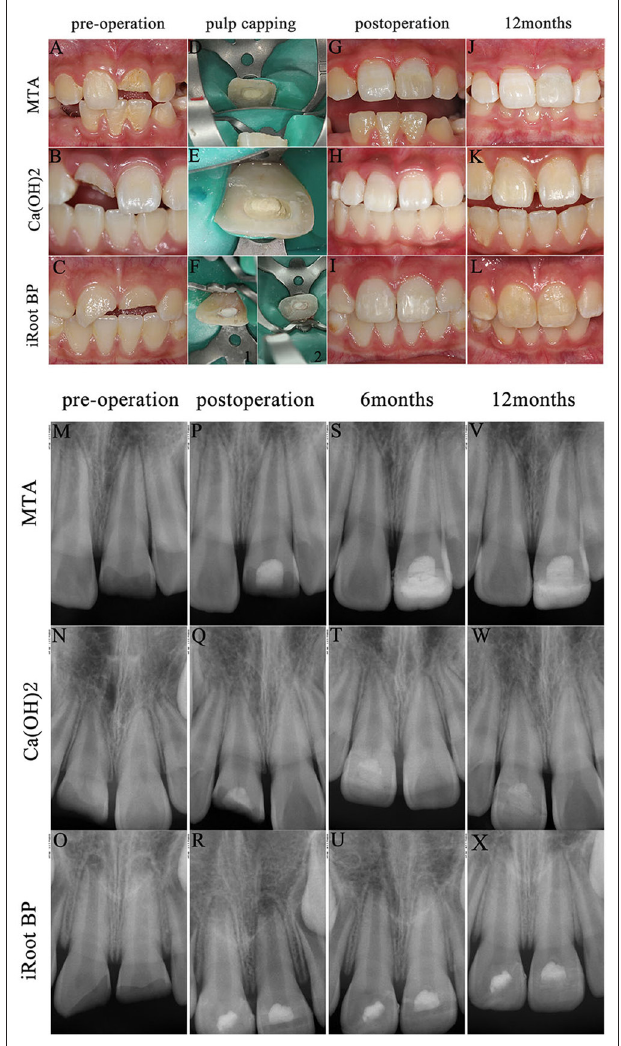
FIGURE 2 | Cases of partial pulpotomy with three pulp-capping agents. (1) Preoperative intraoral photograph (A–C) and radiographs for each specimen (M–O) . Pulp capping process [ D : mineral trioxide aggregate (MTA) (Dentsply Sirona, North Carolina, USA); E : Dycal (Dentsply Sirona, North Carolina,